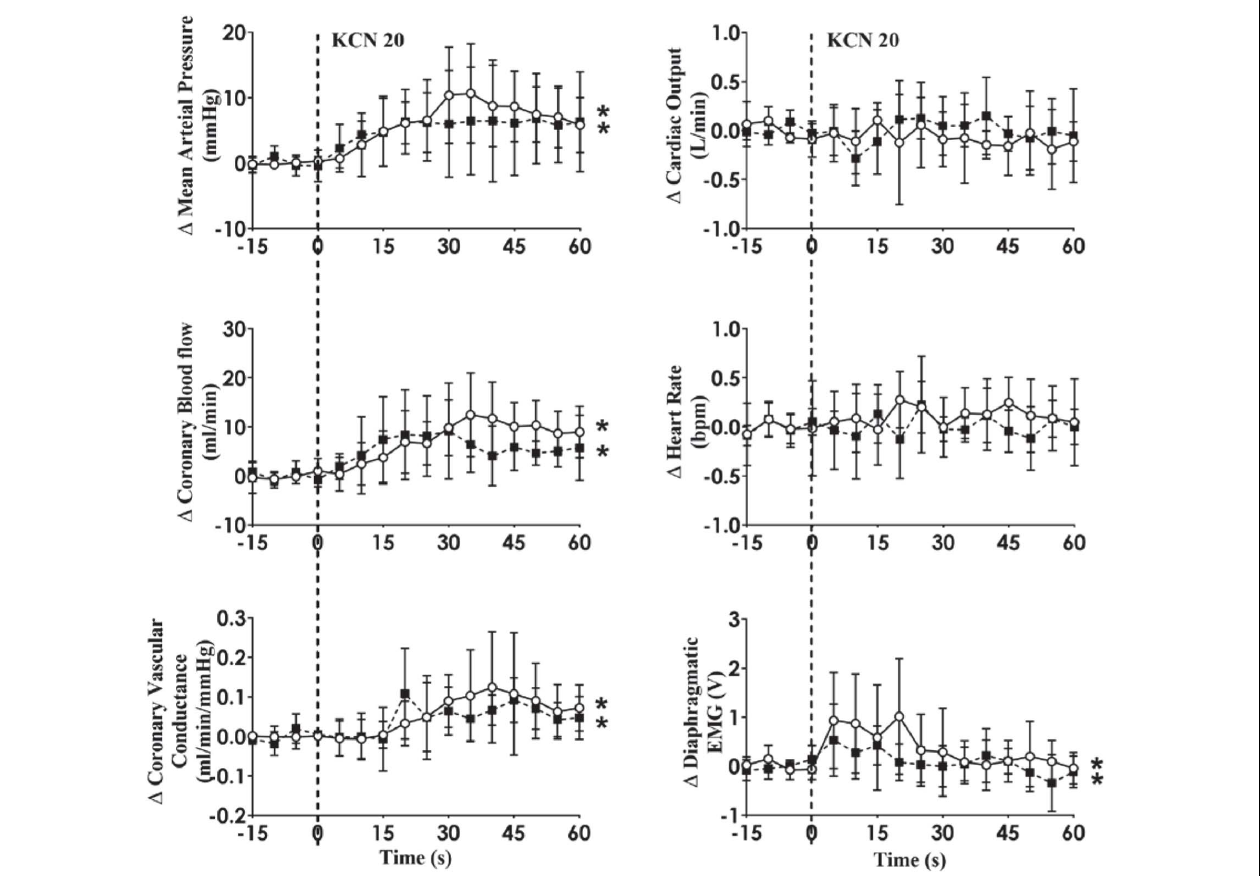
FIGURE 6 | Absolute change in hemodynamic variables to CB activation before and after b-adrenergic receptor blockade (Propranolol; 30 mg bolus followed by 0.5 mg/kg/h infusion for 90 min) in conscious sheep with heart failure. The heart was paced at a constant rate such that the heart rate was unchanged. The open circles and solid line represent the KCN response before propranolol infusion, and filled squares and interrupted line is after propranolol infusion. Results are mean ± SD. * p < 0.05 denotes a significant effect of time (ANOVA, *effect within 1 min time after